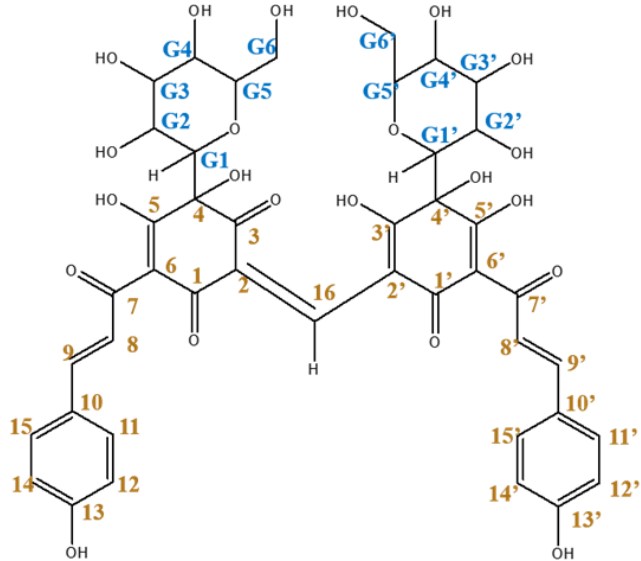
Figure 2. Molecular structure of carthamin.